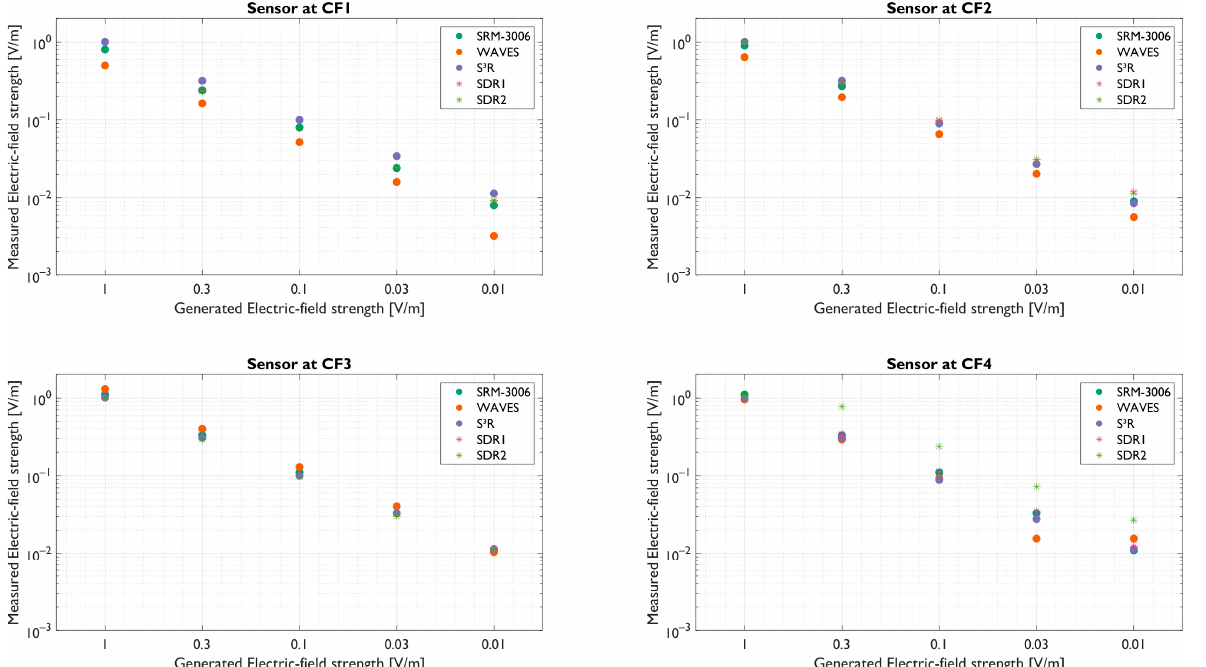
Figure 4. GTEM cell testing for four frequencies. The SRM-3006 is used as baseline. CF1: 773 (S³R and SDR), 806 MHz (WAVES); CF2: 940 MHz (WAVES), 1472 MHz (S³R and SDR); CF3: 1840 MHz (WAVES), 2140 MHz (S³R and SDR); CF4: 3600 MHz (WAVES, S³R and SDR).